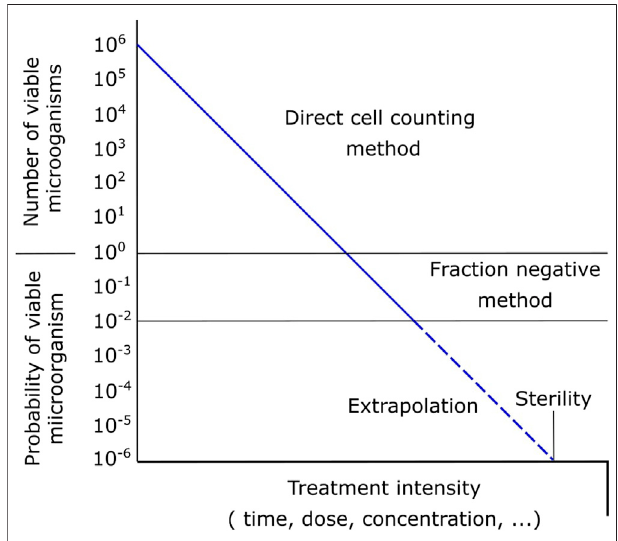
FIGURE 1 | Ideal inactivation kinetics of microorganisms analyzed by different methods